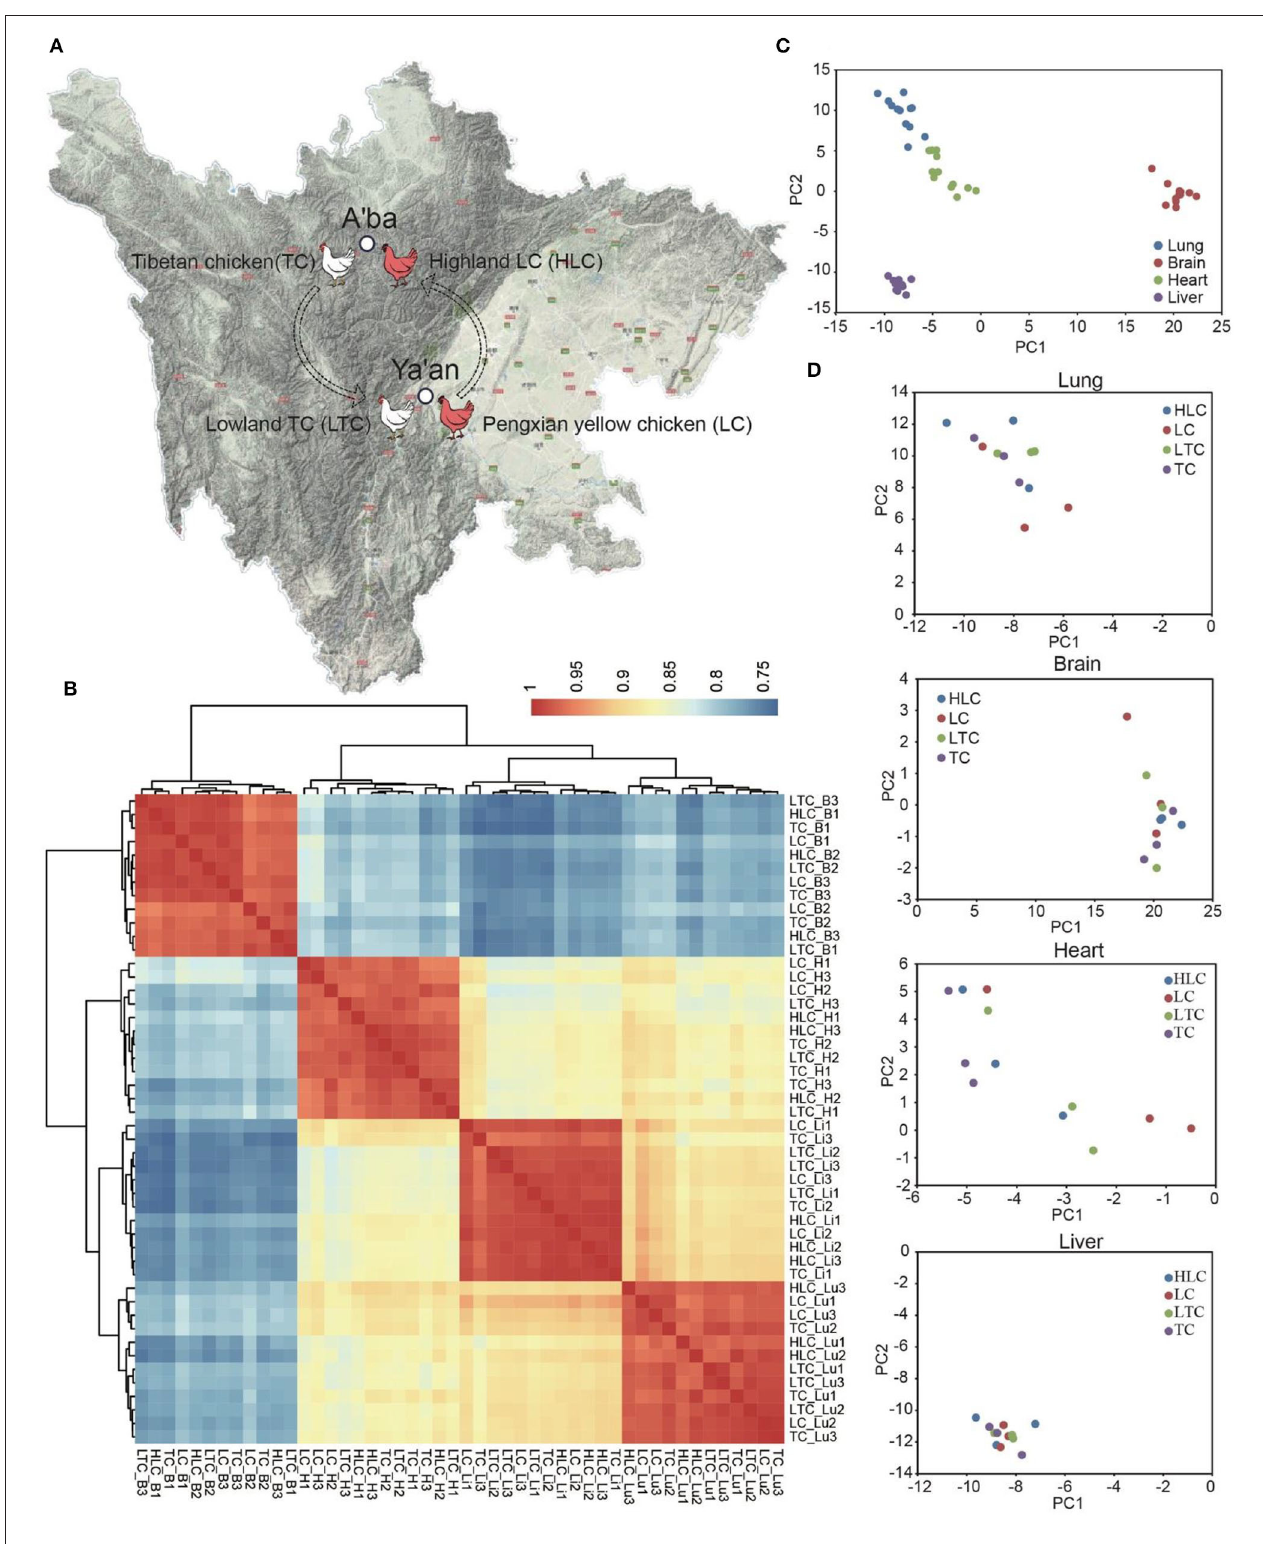
FIGURE 1 | The locations and animal groups of this study. (A) Sample collection sites. As the gray deepens, the altitude gets higher. The color of the chicken in this picture does not represent the real color of Tibetan chicken and Peng’xian yellow chicken. (B) Heatmap shows the correlation of all samples by Pearson correlation analysis based on CPM (B, H, Li, and Lu represent brain, heart, liver, and lung, respectively). (C,D) PCA plots show the difference in all samples and the samples of the same tissue.